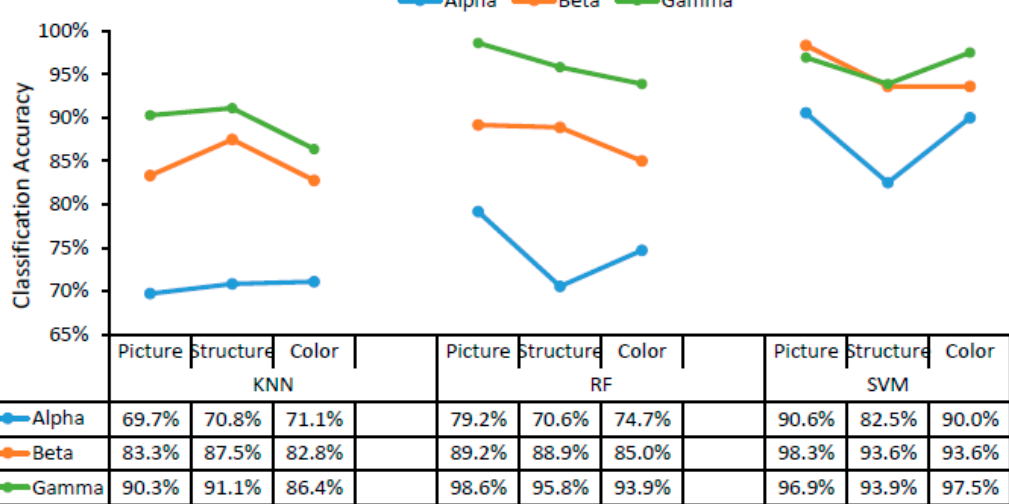
Figure 3. The accuracy of color, structure, and landscape image classification as a function of brain waves. KNN, K-nearest neighbor; RF, random forest; SVM, support vector machine.